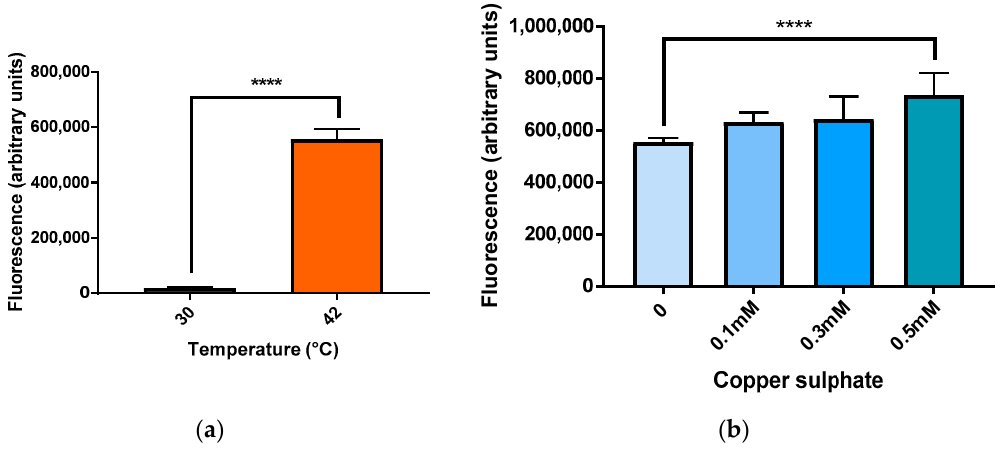
Figure 3. mCherry fluorescence in BY4743 [pYHSRed1] under heat and copper stress. ( a ) heat stress; ( b ) stress due to copper sulphate. Data shown as mean ± SEM of triplicate measurements; **** p < 0.0001.